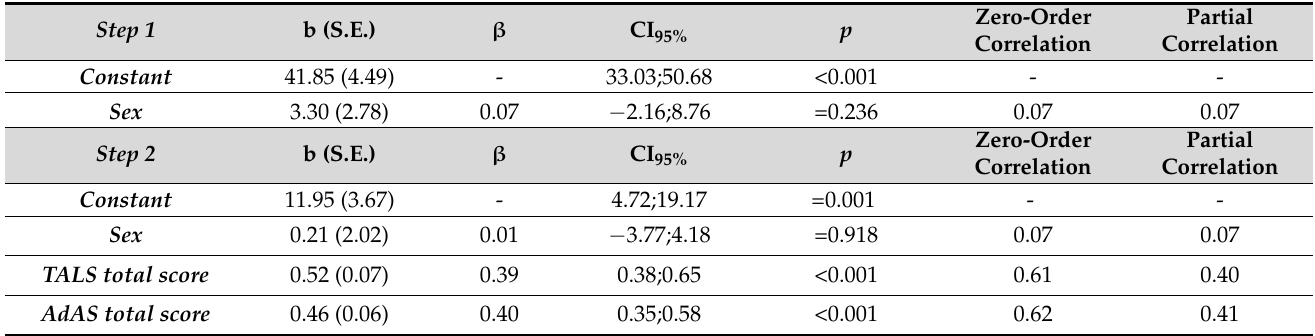
Table 5. Hierarchical linear model of predictors of MOOD total score: sex as predictive variable in the first block and Tals and AdAS total scores as predictive variables in the second block.